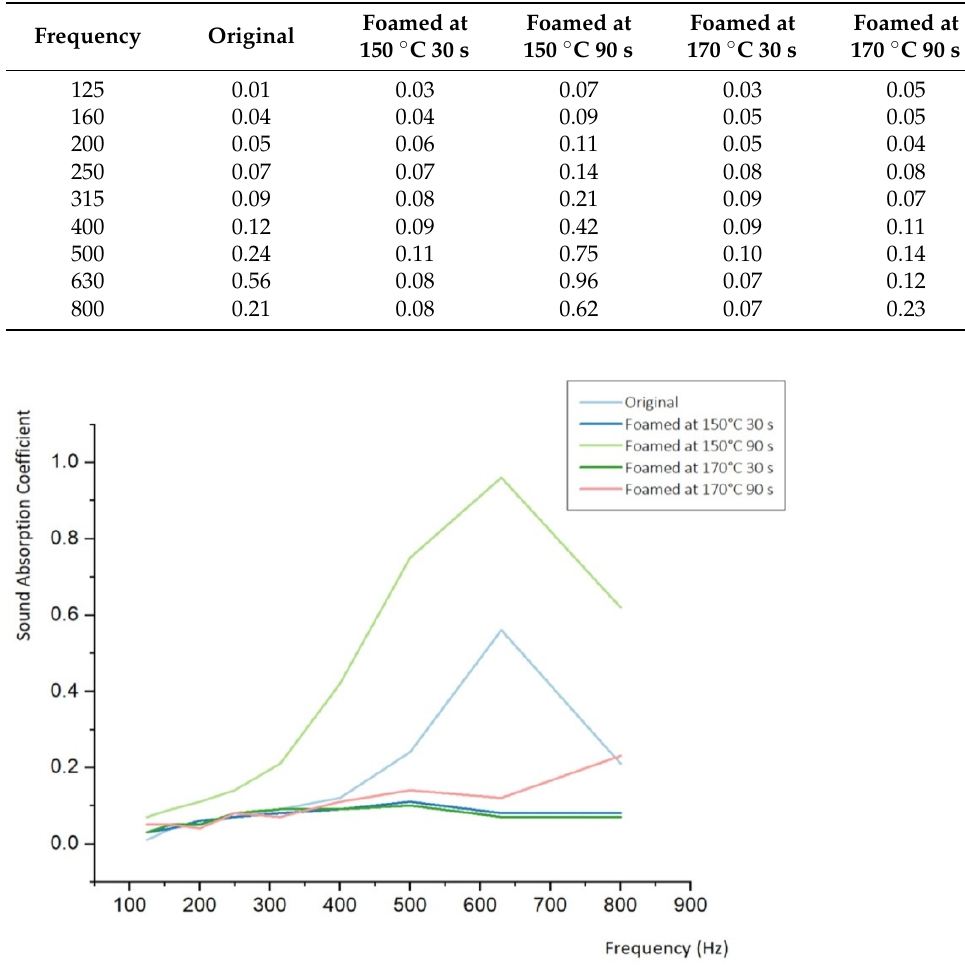
Table 5. Results of SAC for measuring at low-frequency.